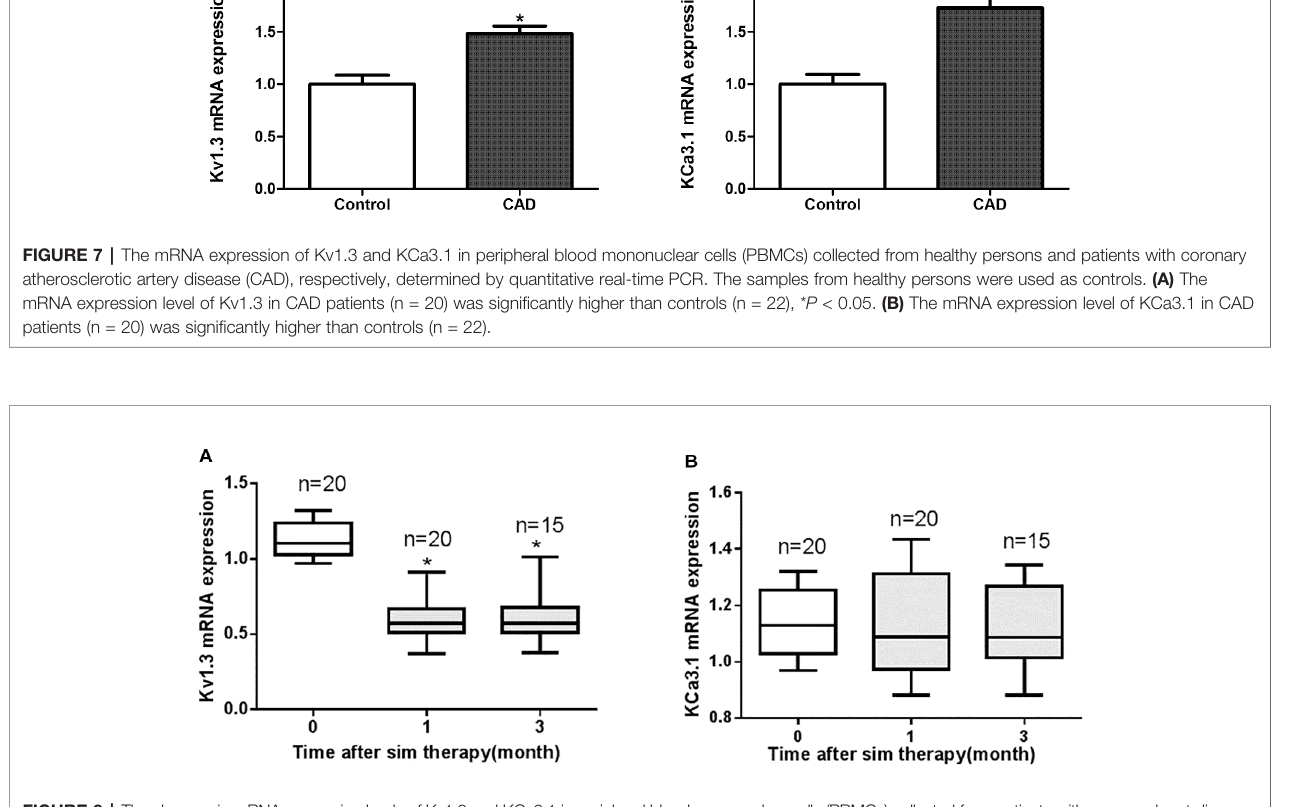
FIGURE 8 | The changes in mRNA expression levels of Kv1.3 and KCa3.1 in peripheral blood mononuclear cells (PBMCs) collected from patients with coronary heart disease (CAD) prior to therapy (0 month, n=20), 1 month (n=20), and 3 months (n=15) after 40 mg per day simvastatin therapy, as measured by real-time PCR. (A) Simvastatin therapy signi fi cantly reduced the mRNA expression level of Kv1.3 compared with the level before simvastatin therapy (0 month), * P < 0.05; (B) Simvastatin had no signi fi cant effect on the mRNA expression level of